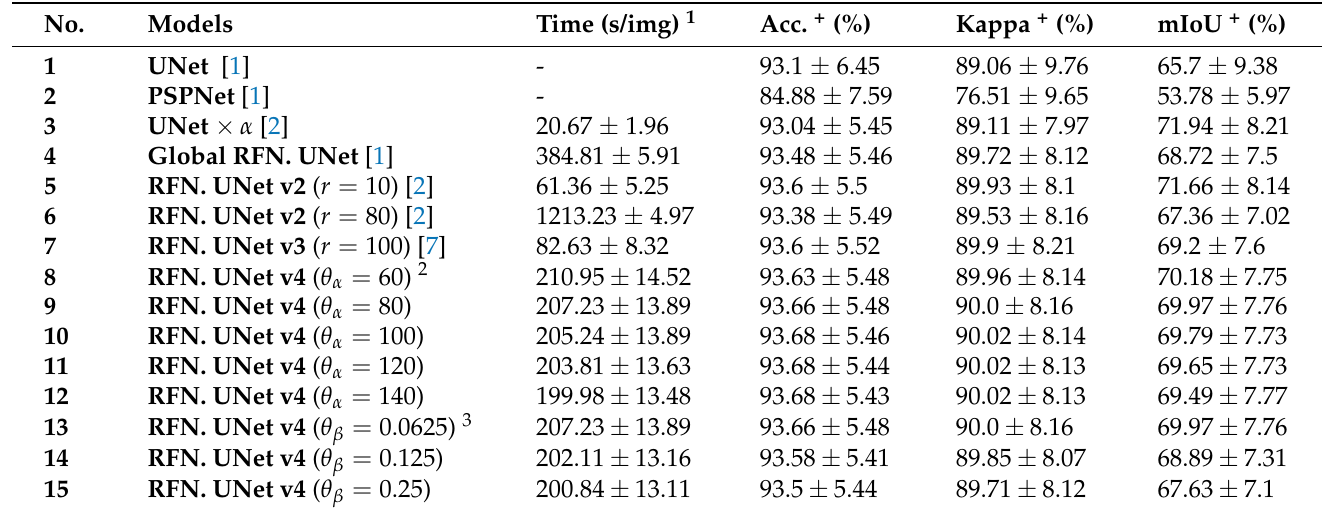
Table 1. Average Time, Accuracy, Kappa, and mIoU Scores on Our Landsat 8 OLI Test Set (Mean ± Standard Deviation, + represents that higher scores indicate better